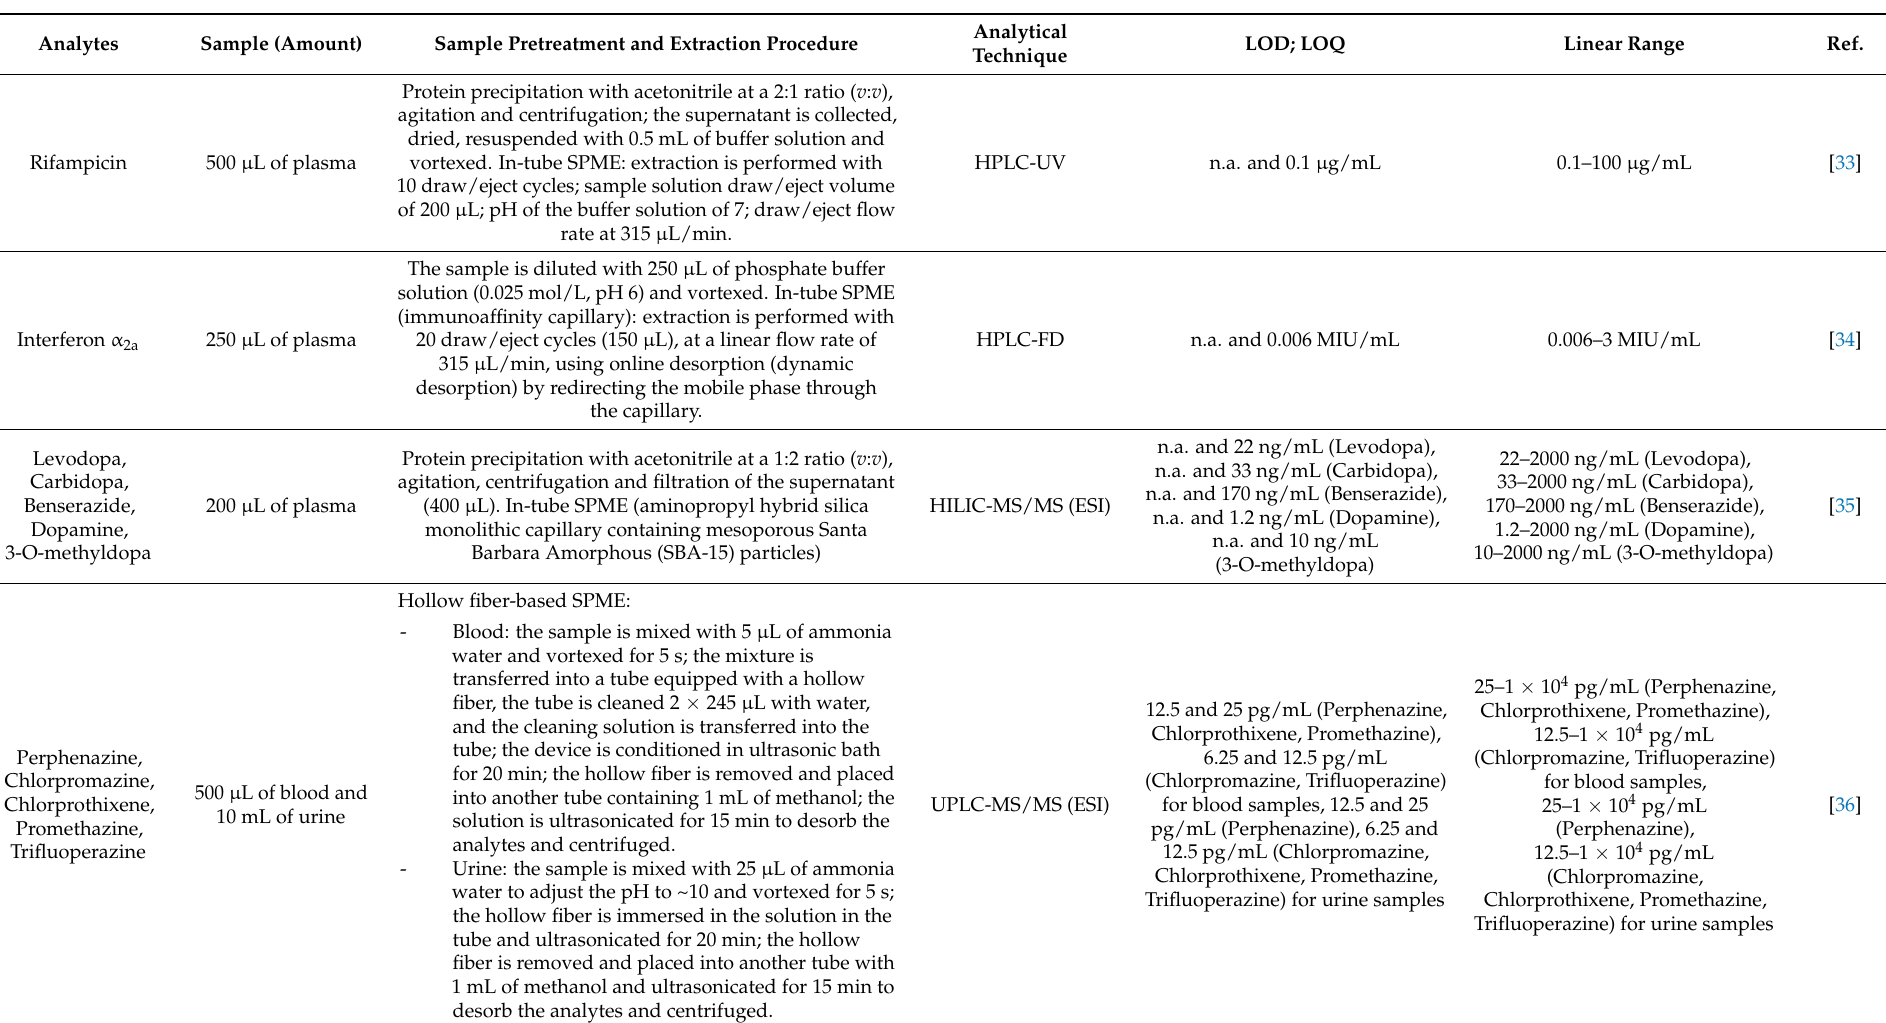
Table 4. Bioanalytical procedures using SPME and in tube-SPME approaches for